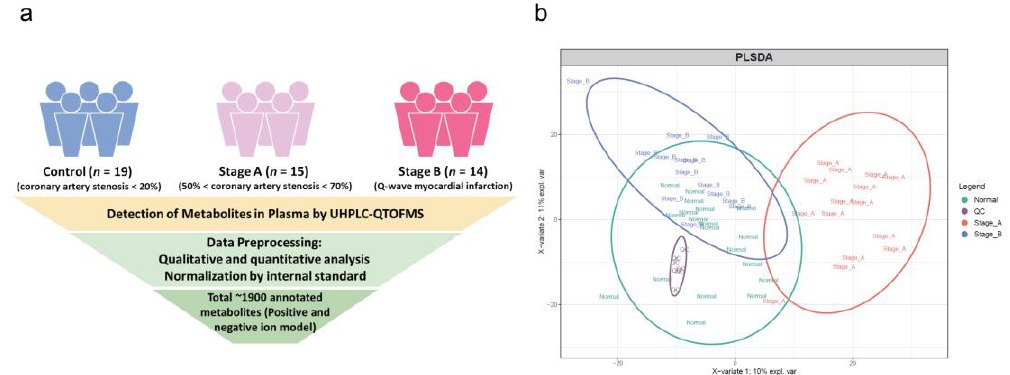
Figure 1. ( a ) The schematic diagram of study design; ( b ) partial least squares discriminant analysis (PLSDA) of global plasma metabolomics profile.